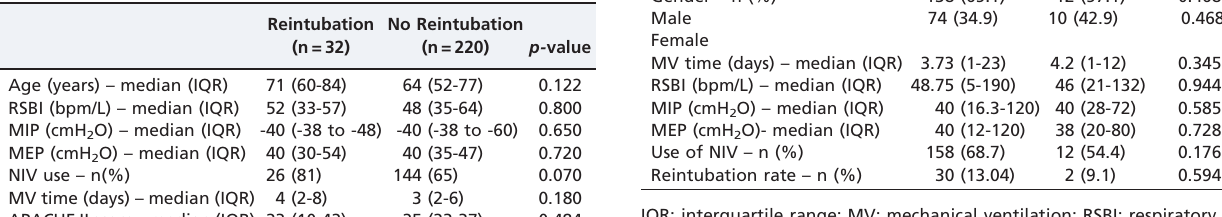
Table 2 - Comparison of the characteristics of patients who did and did not require reintubation.